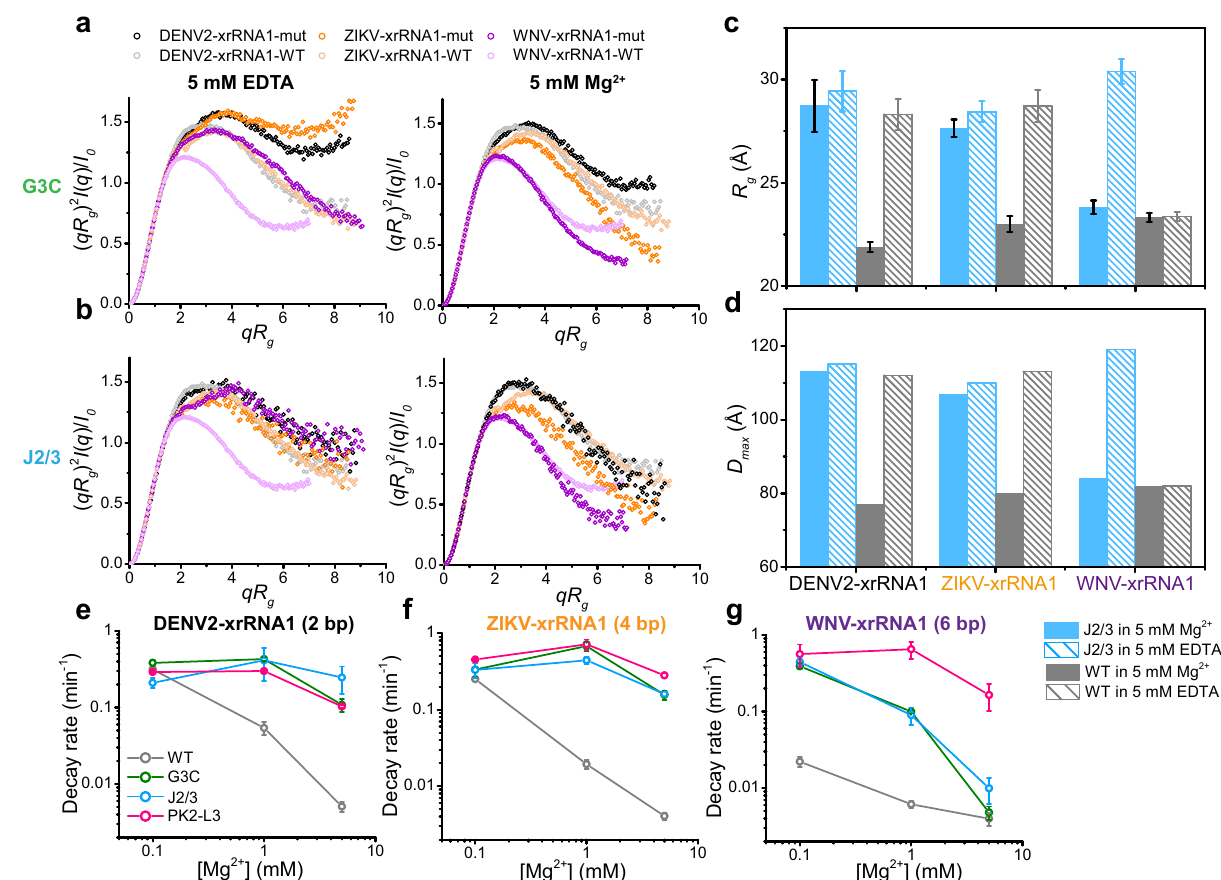
Fig. 5 Mutations at key tertiary motifs affect the structure and Xrn1 resistance of fl aviviral xrRNAs. a – b The dimensionless kratky plots for G3C ( a ) and J2/3 ( b ) mutants of xrRNA1s from DENV2, ZIKV, and WNV in the presence of 5 mM EDTA (left) or 5 mM Mg 2 + (right). c – d R g ( c ) and D max ( d ) for the wild type and J2/3 mutants of xrRNA1s from DENV2, ZIKV, and WNV in 5 mM Mg 2 + or 5 mM EDTA. Each column in c represents an independent experiment with n = 1 and the error bars are propagated uncertainties calculated by GNOM. e – g The relative Xrn1 decay rates for the wild type, PK1, J2/3, and PK2-L3 mutants of DENV2-xrRNA1 ( e ), ZIKV-xrRNA1 ( f ), and WNV-xrRNA1 ( g ) at various Mg 2 + concentrations. The decay rates were calculated by fi tting the fl uorescence traces (see supplementary Fig. 8d – l) with a single exponential curve. Data are presented as mean ± SEM. n = 3 biologically independent samples examined over three independent experiments in e – g . Source data for a , e – g are provided as a Source Data fi